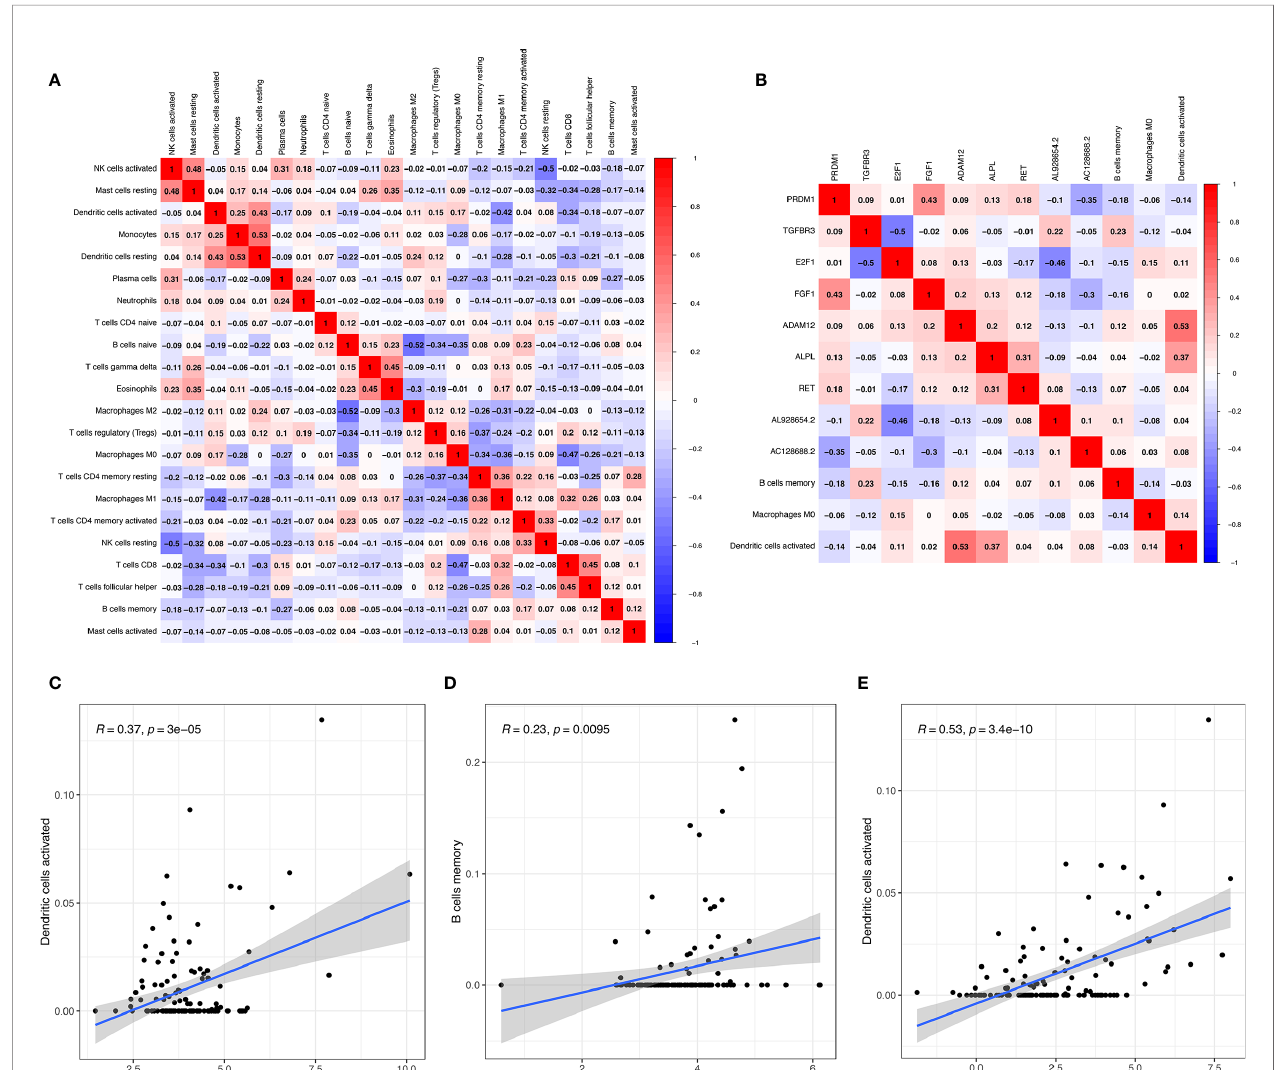
FIGURE 7 | Signi fi cant co-expression patterns between proportions of immune cells (A) ; signi fi cant co-expression patterns between ceRNA and immune cells (B) ; the fraction of activated dendritic cells was positively associated with ALPL expression (C) ; the memory B cells were positively associated with TGFBR3 expression (D) ; the dendritic cell activated were positively associated with ADAM12 (E)